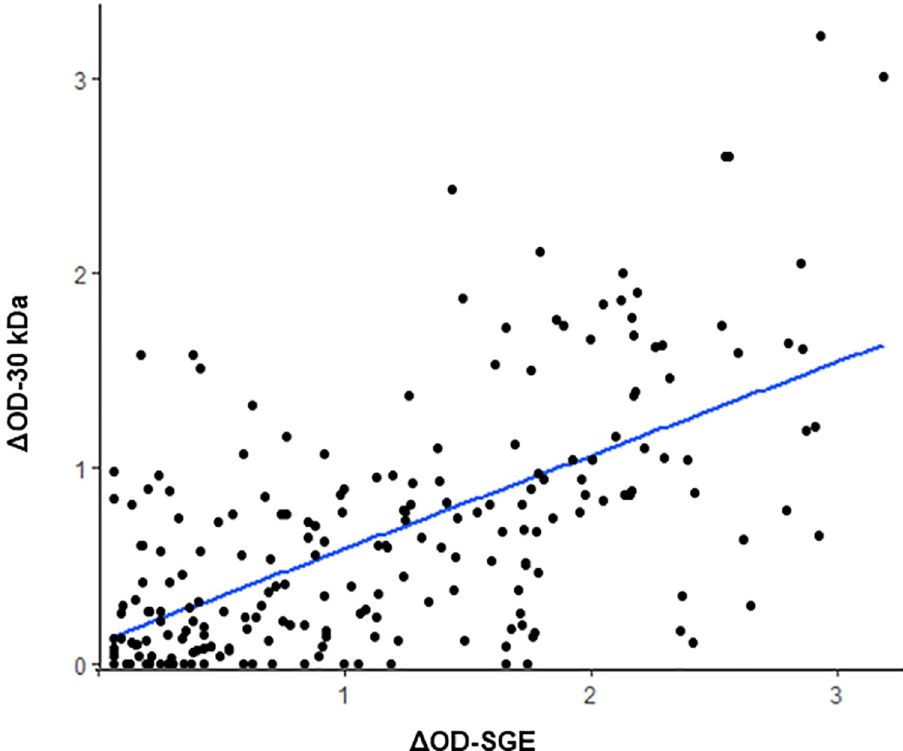
Fig 5. Correlation between IgG specific response to Cx . quinquefasciatus SGE and the 30 kDa recombinant protein. Scatter plot analysis of IgG responses to both salivary antigens is presented, and the Δ OD values among the 223 children are